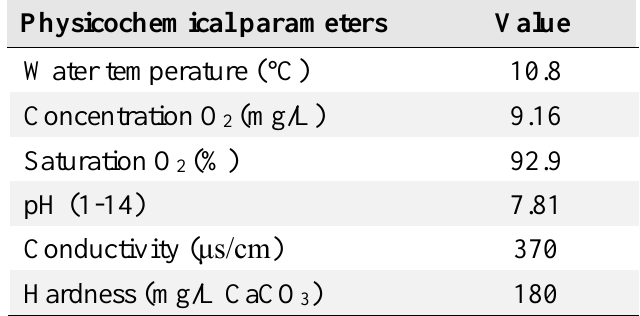
Table 1. Physicochemical parameters of the investigated locality in Karamejdan Lake.